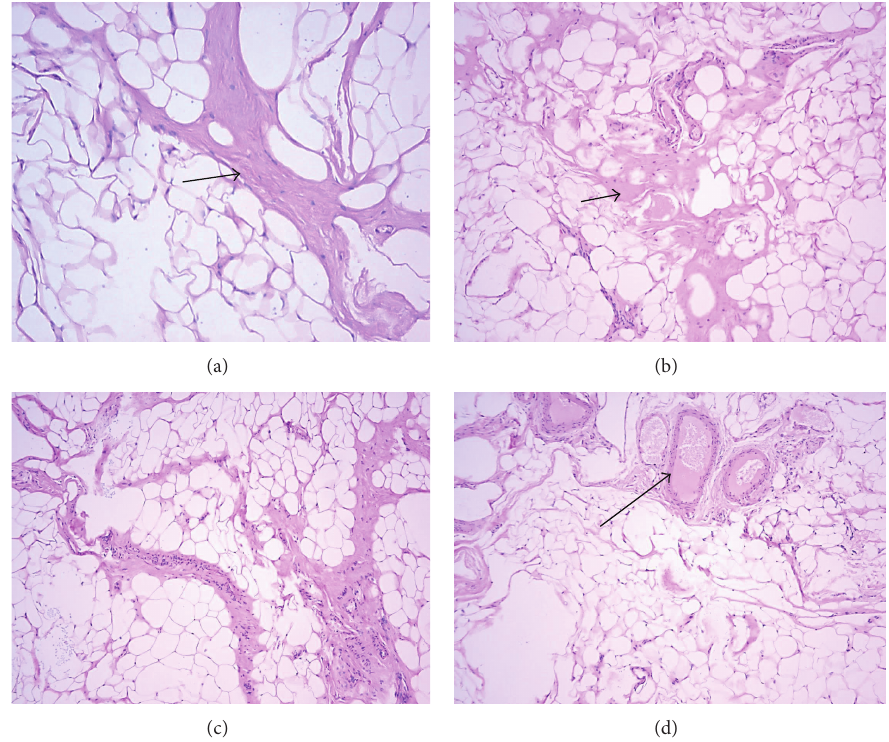
Figure 2: Hematoxylin and Eosin staining in paraffin embedded sections. (a) Mild type of GO. The arrow head shows the area of the intense fibrosis. Magn. 400x, 100x. (b) Mild type of GO. The arrow head shows the small blood vessels. Magn. 400x, 100x. (c) Severe type of GO. Significant proliferation of the fibrous connective tissue within the fat. Magn. 400x. (d) The arrow head shows the prominent blood vessels within the fatty tissue in the severe GO orbitopathy. Magn. 200x.